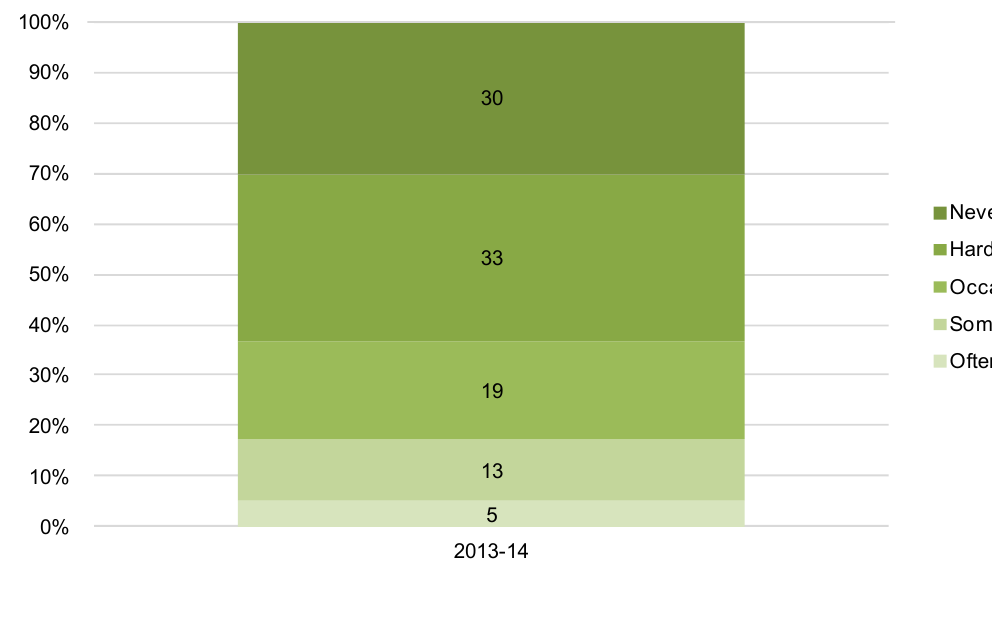
Figure 8: How often people felt lonely,